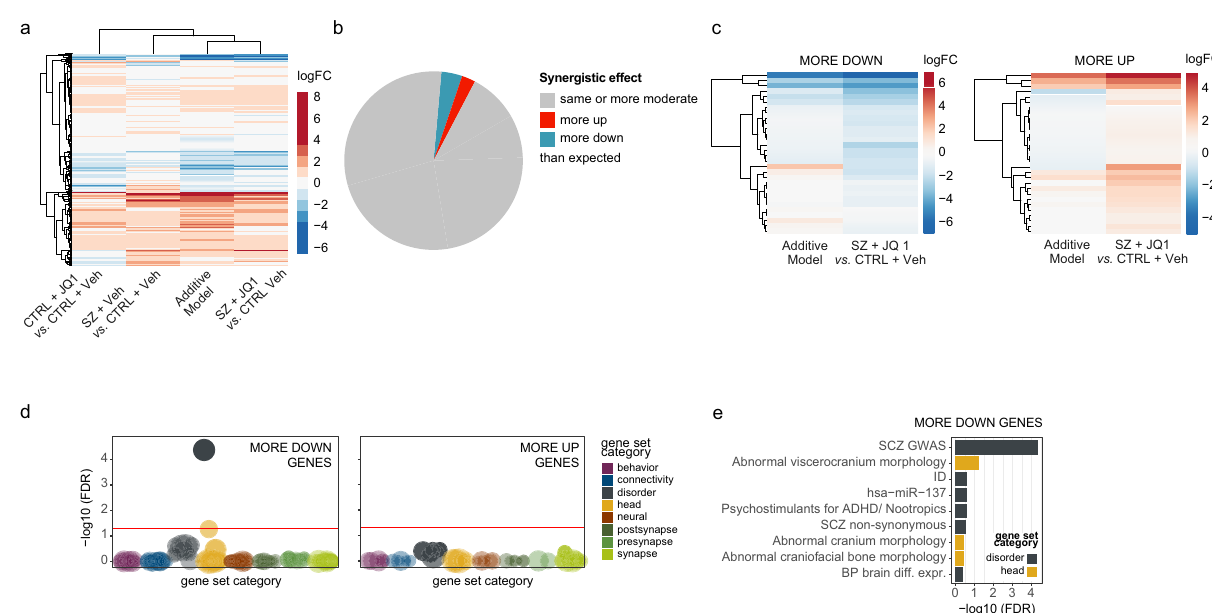
Fig. 4 Synergistic effects of SZ and JQ1 treatment in hiPSC-derived neurons. a Hierarchical clustering of the t -statistics for all comparisons. The color gradient represents t -statistic values. b Pie chart showing percentages of genes that exhibit similar or more moderate differential expression (gray) in SCZ samples following JQ treatment, in comparison with the additive model, as well as genes that are more downregulated (blue) and more upregulated (red). c Hierarchical clustering of the differential expression log2 fold-changes of “ more downregulated ” and “ more upregulated ” genes, in the additive model vs. the JQ1-treated SZ neurons. d Over-representation analysis (ORA) using a hypergeometric test, of 698 curated gene sets and those “ more down ” and “ more up ” genes with synergistic differential expression, ranked by adjusted signi fi cance. e Bar chart showing more detailed ORA results of the “ more down ” genes as in d